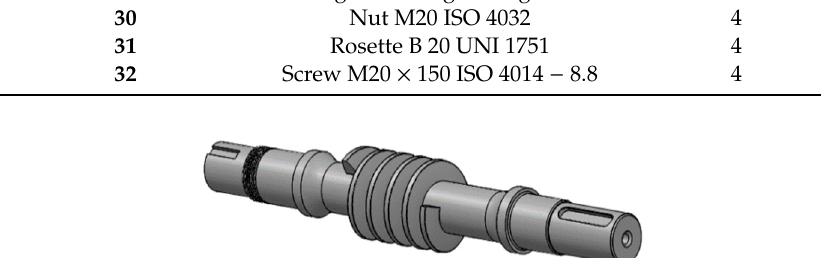
Table 2. Constructive data.